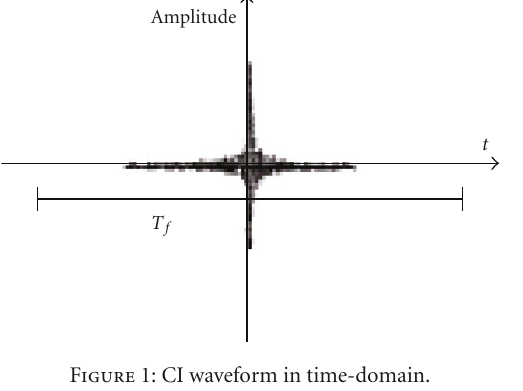
Figure 1: CI waveform in time-domain.